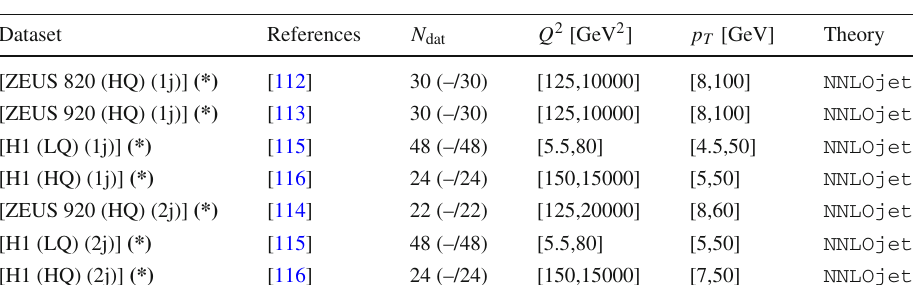
Table 2 Same as Table 1 for DIS jet data